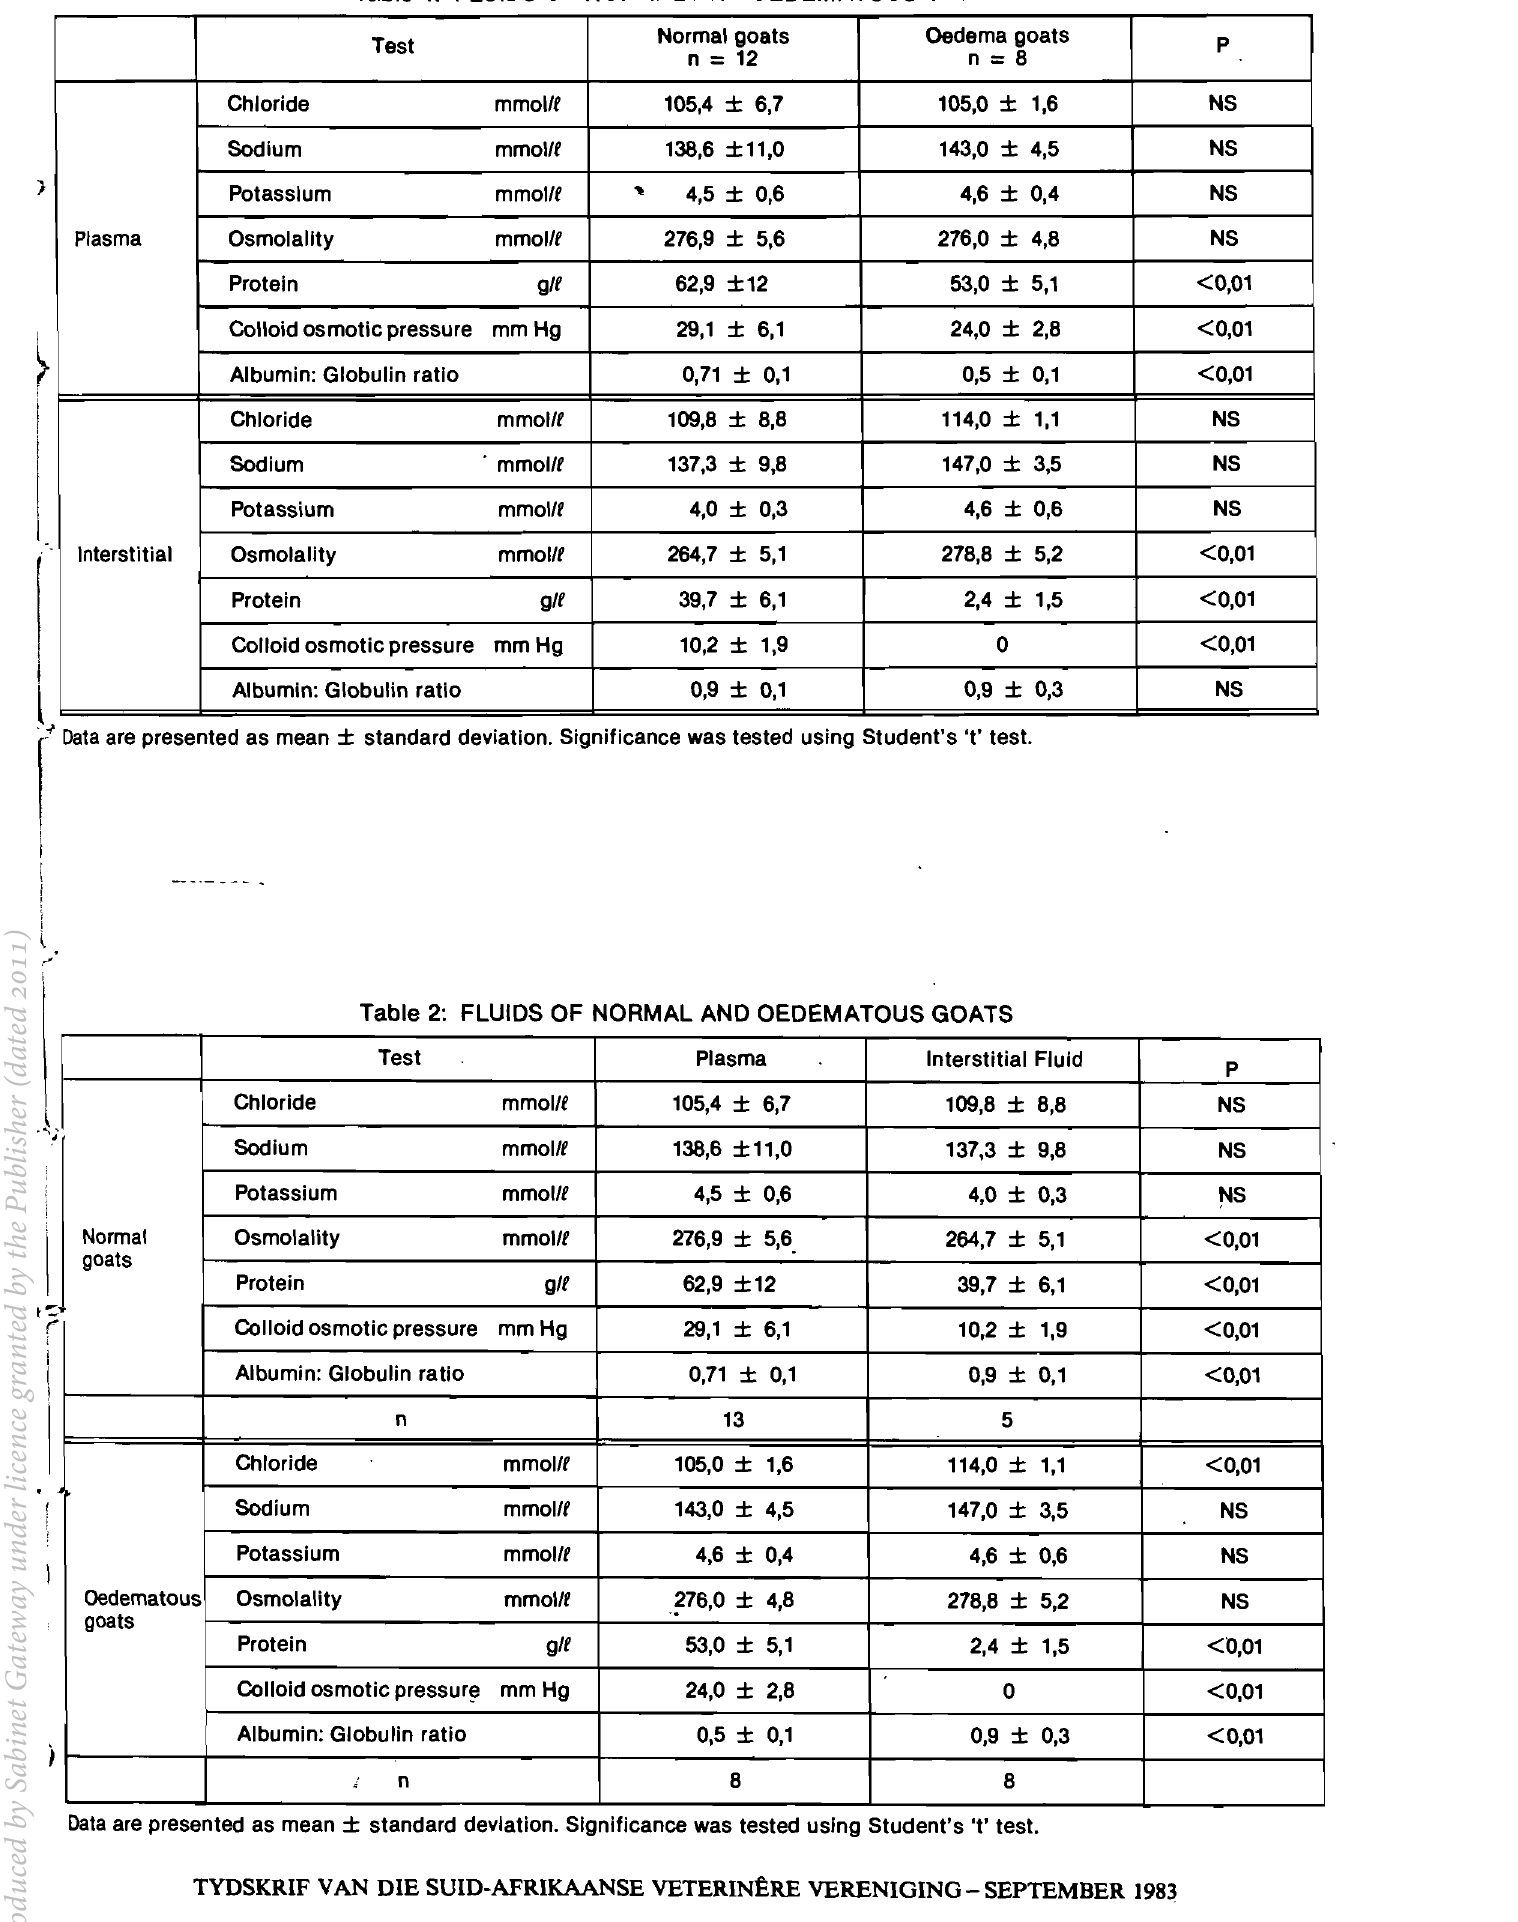
Table 2: FLUIDS OF NORMAL AND OEDEMATOUS